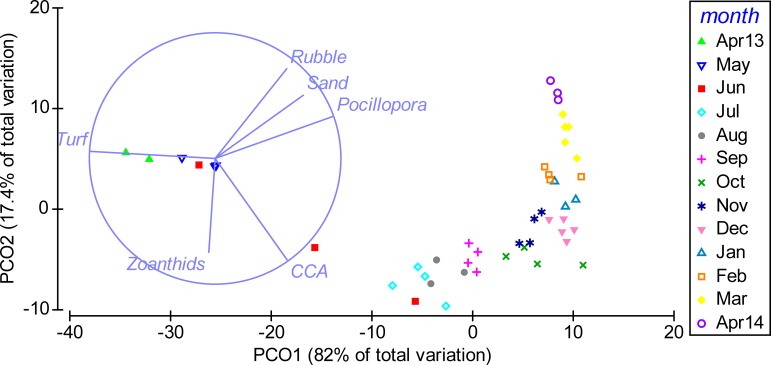
Temporal shift in benthic community composition.Weekly sampling data from April 2013 to April 2014 were grouped by the factor month. The distance between data points reflects their similarity in benthic community composition (close = similar) and the shift along axes can be assigned to changes in benthic cover types (arrows). PCO1 correlates positively to cover of Pocillopora spp. (Pocillopora) (Pearson correlation, r = 0.94), sand (r = 0.70), rubble (r = 0.57) and crustose coralline algae (CCA) (r = 0.57) and negatively to turf algae (Turf) (r = − 0.99). PCO2 correlates positively to rubble (r = 0.71) and sand (r = 0.51) and negatively to CCA (r = − 0.81) and zoanthids (r = − 0.75). Only variables with r > 0.5 are displayed.